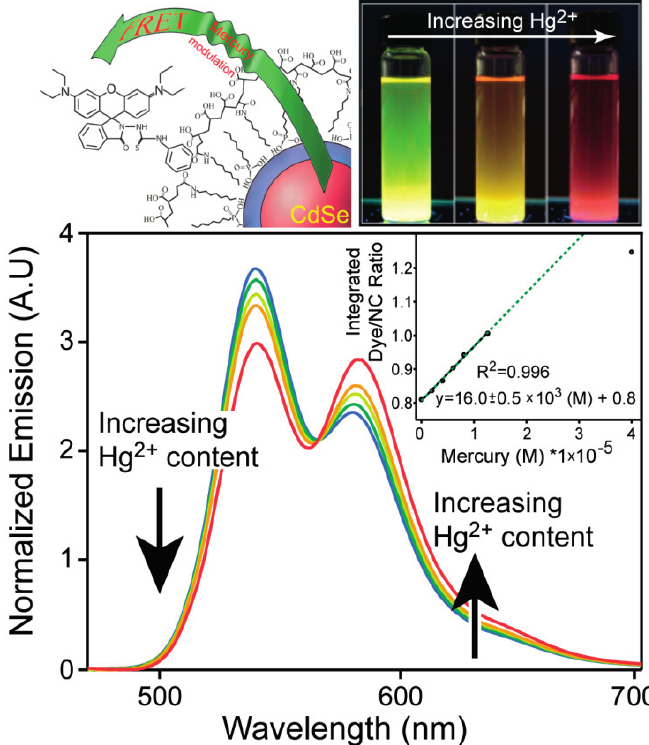
Figure 8. The ratiometric response of the sensor as a function of Hg 2+ content (reprinted with permission from [98], Copyright 2011 The Royal Society of